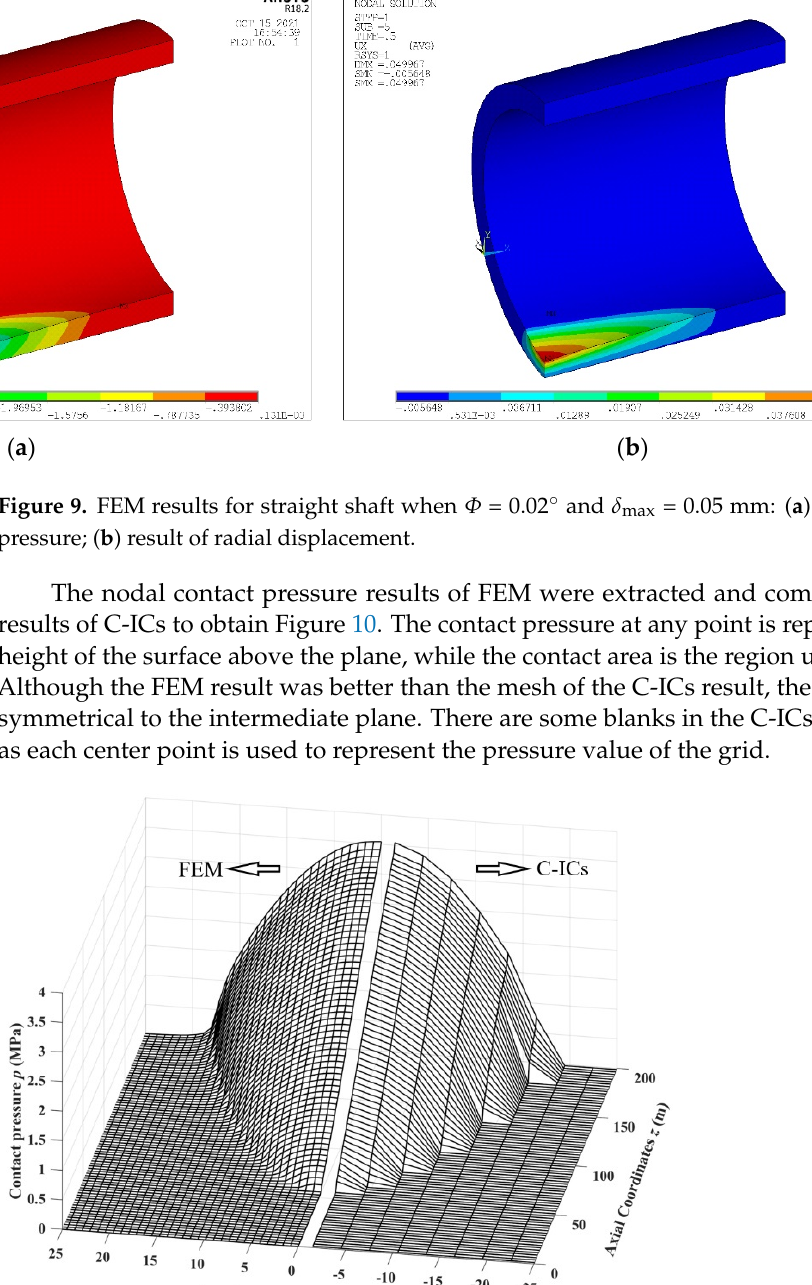
Figure 10. Comparison of results between FEM and the C-ICs method when Φ = 0.02° and δ max = 0.05 mm.